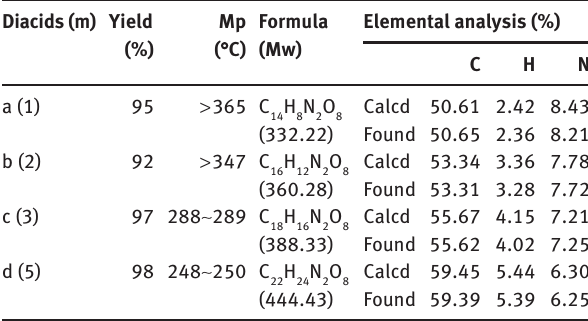
Table 1: Yields, melting point, and molecular weight of the aromatic diimide-diacids